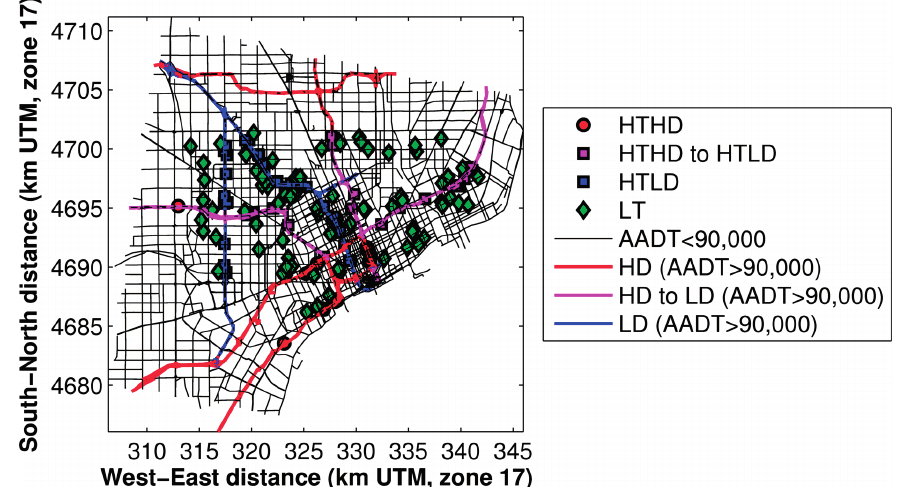
Figure 11. NEXUS study domain, after making adjustments in diesel impact. Interstates (HD) and participants within 150 m of high-traffic/high-diesel (HTHD) roadways are shown in red; freeways (LD) and participants within 150 m of low-diesel/high-traffic roadways are shown in blue; control-group participants >300 m from interstates or freeways are in green; and participants and roadways that were reclassified from HD to LD are shown in magenta.